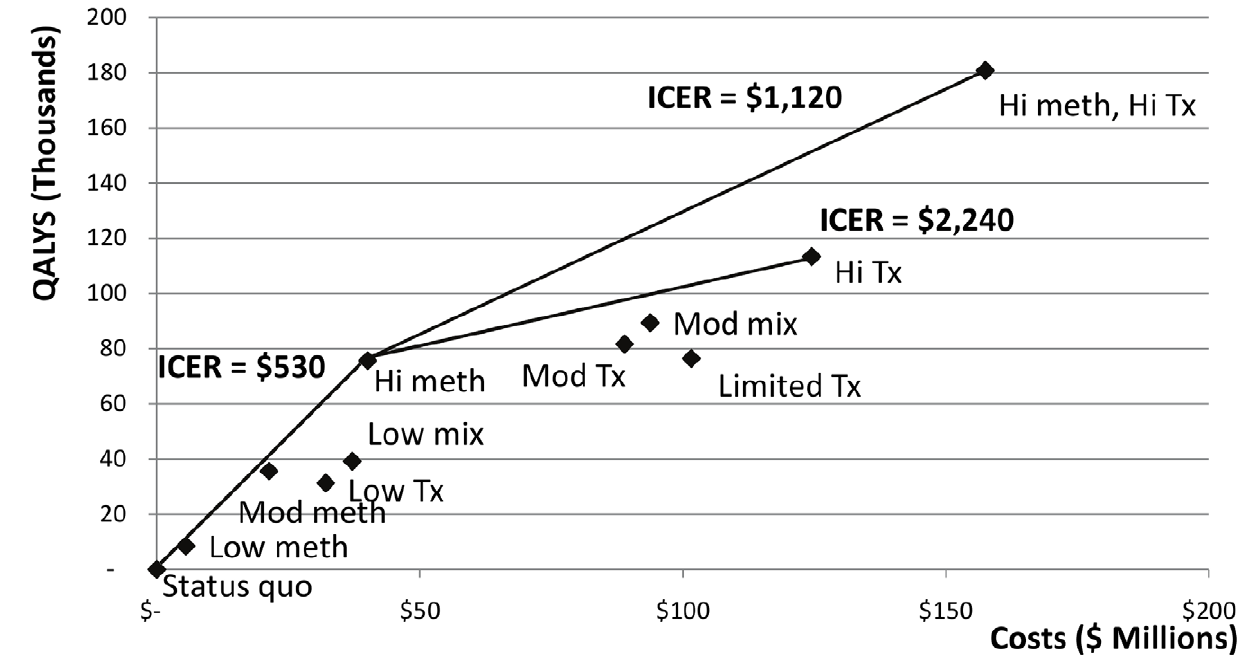
Figure 4. Cost effectiveness of various strategies for scaling up methadone substitution therapy and ART access in Ukraine, assuming that scaling up methadone substitution therapy is a feasible option. Status quo, no methadone substitution therapy slots, 10% of eligible non-IDUs on ART, 2% of eligible IDUs on ART; Low meth, 3.1% of IDUs on methadone substitution therapy, ART according to status quo except 25% of eligible IDUs on methadone substitution therapy on ART; Mod meth, 12.5% of IDUs on methadone substitution therapy, ART according to status quo except 25% of eligible IDUs on methadone substitution therapy on ART; Hi meth, 25% of IDUs on methadone substitution therapy, ART according to status quo except 25% of eligible IDUs on methadone substitution therapy on ART; Low mix, 3.1% of IDUs on methadone substitution therapy, 20% of eligible non-IDUs and IDUs not on methadone substitution therapy on ART, 25% of IDUs on methadone substitution therapy on ART; Mod mix, 3.1% of IDUs on methadone substitution therapy, 50% of all eligible patients on ART; Low tx, no methadone substitution therapy slots, 20% of all eligible patients on ART; Mod tx, no methadone substitution therapy slots, 50% of all eligible patients on ART; Hi tx, no methadone substitution therapy slots, 80% of all eligible patients on ART; Limited tx, no methadone substitution therapy slots, 80% of eligible non- IDUs on ART, 10% of eligible IDUs on ART; Hi meth, Hi tx, 25% of IDUs on methadone substitution therapy, 80% of all eligible patients on ART.